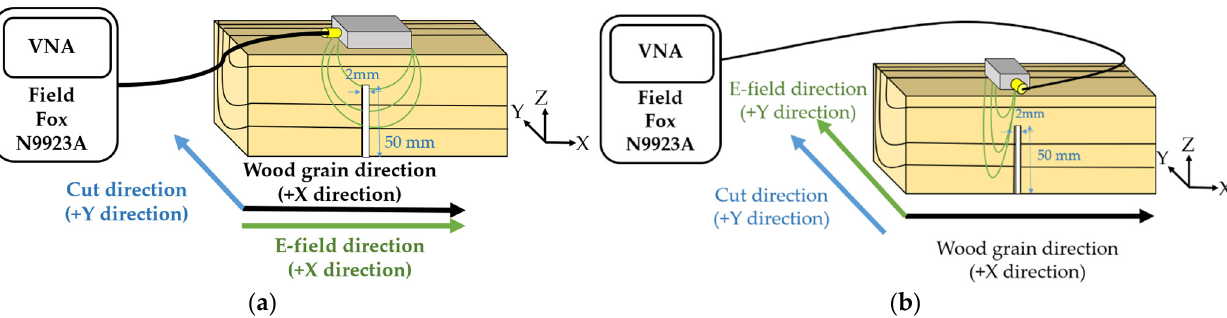
Figure 12. ( a ) E-field parallel to the wood grain and perpendicular to the cut (reverse side); ( b ) E-field perpendicular to the wood grain and parallel to the cut (reverse side).